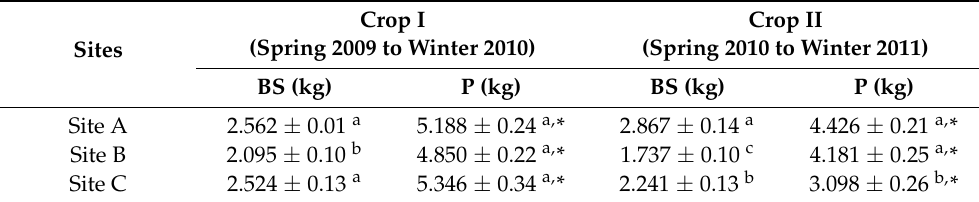
Table 2. Average resin production per tree in pine plantations of three different